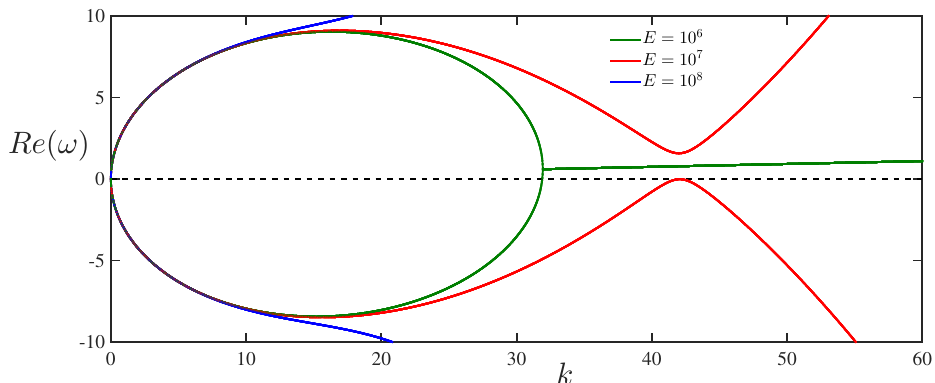
Figure 6. Influence of ice elasticity on the dispersion curves for the particular airflow velocity U = 16.09